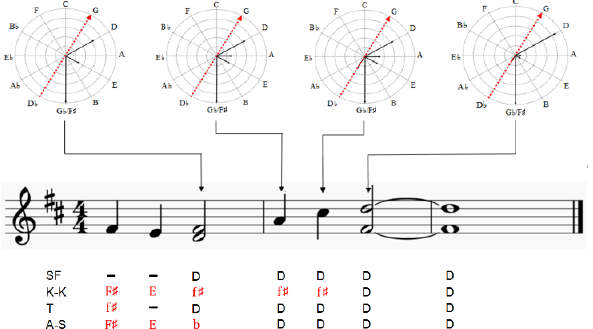
Figure 7. The results of the music key-detection obtained for the method implementing the signature of fifths (SF) as well as for the strictly correlational approaches based on the music key-profiles of Krumhansl–Kessler (K-K), Temperley (T), and Albrecht–Shanahan (A-S), observed for the successively increased length of an analyzed music fragment—the weighting of individual pitch-classes was realized with their aggregate durations (incorrectly detected keys are marked in red).